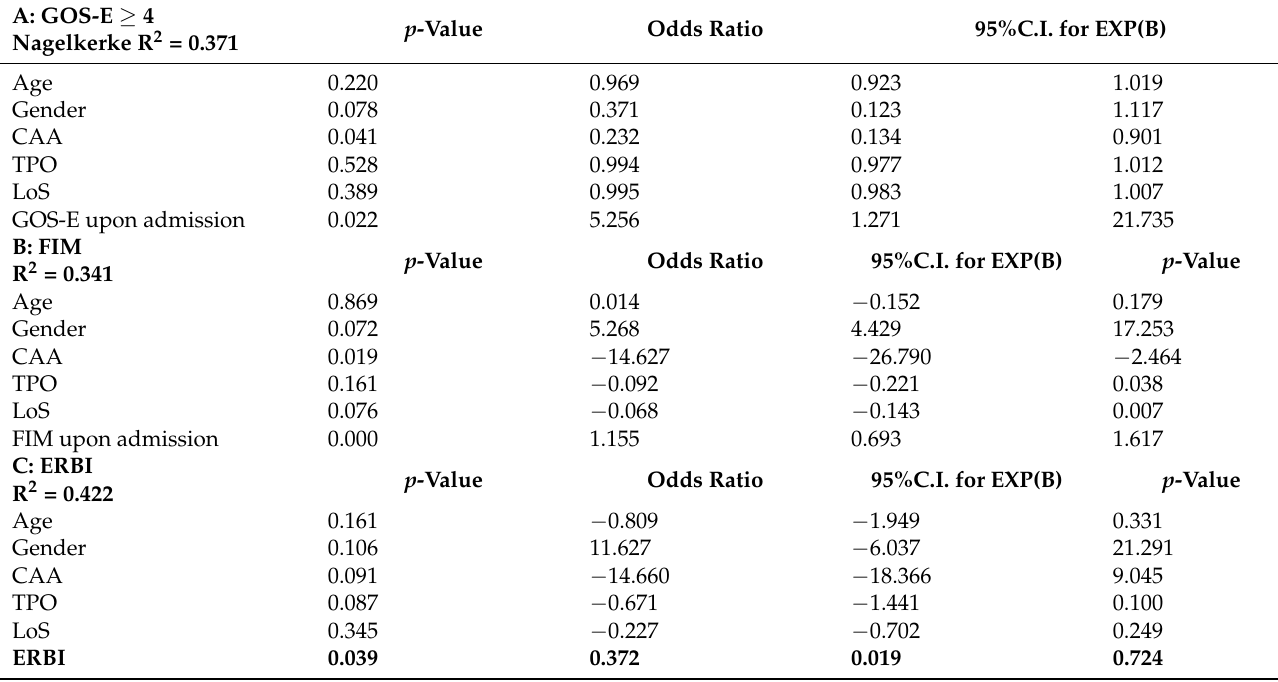
Table 4. Multivariate analysis: (A) GOS-E > 4; (B) FIM score; (C) ERBI score at